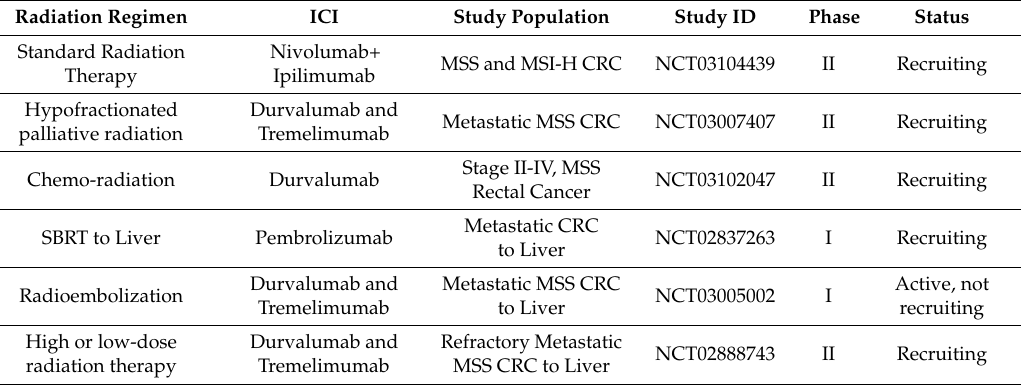
Table 3. Clinical trials of combination ICIs and radiotherapy in CRC